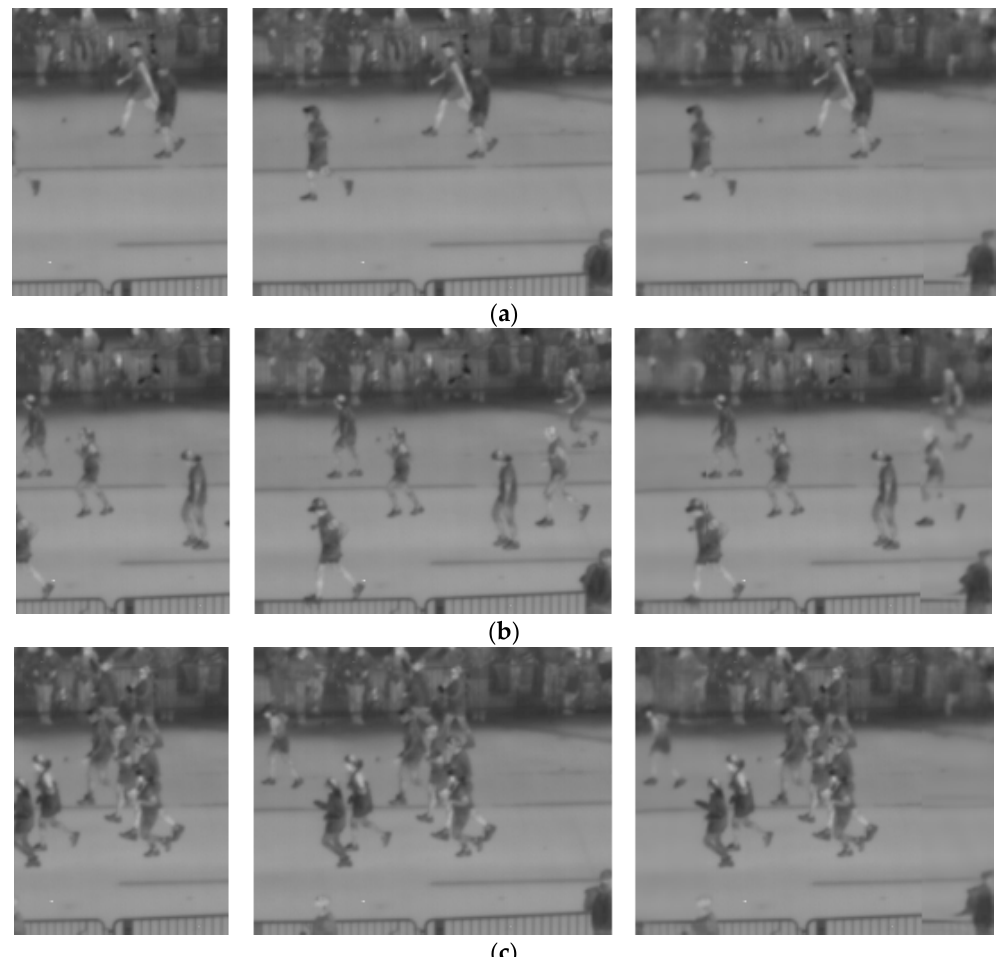
Figure 8. Examples of result images obtained by predLreg and predLRreg (proposed method): from left to right, input, GT , and output images obtained by ( a ) predLreg and ( b ) predLRreg (proposed method).